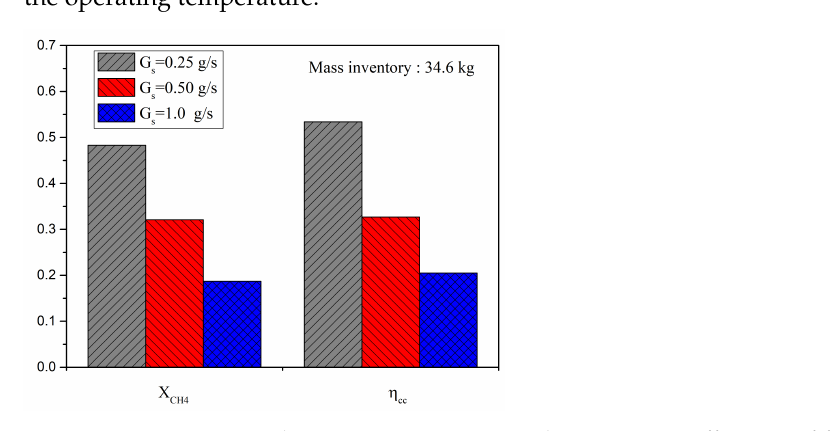
Figure 10. Time-averaged conversion rate CH4 and CO 2 capture efficiency of fuel reactor under different inlet rate. The solid inventory is 34.6 kg.